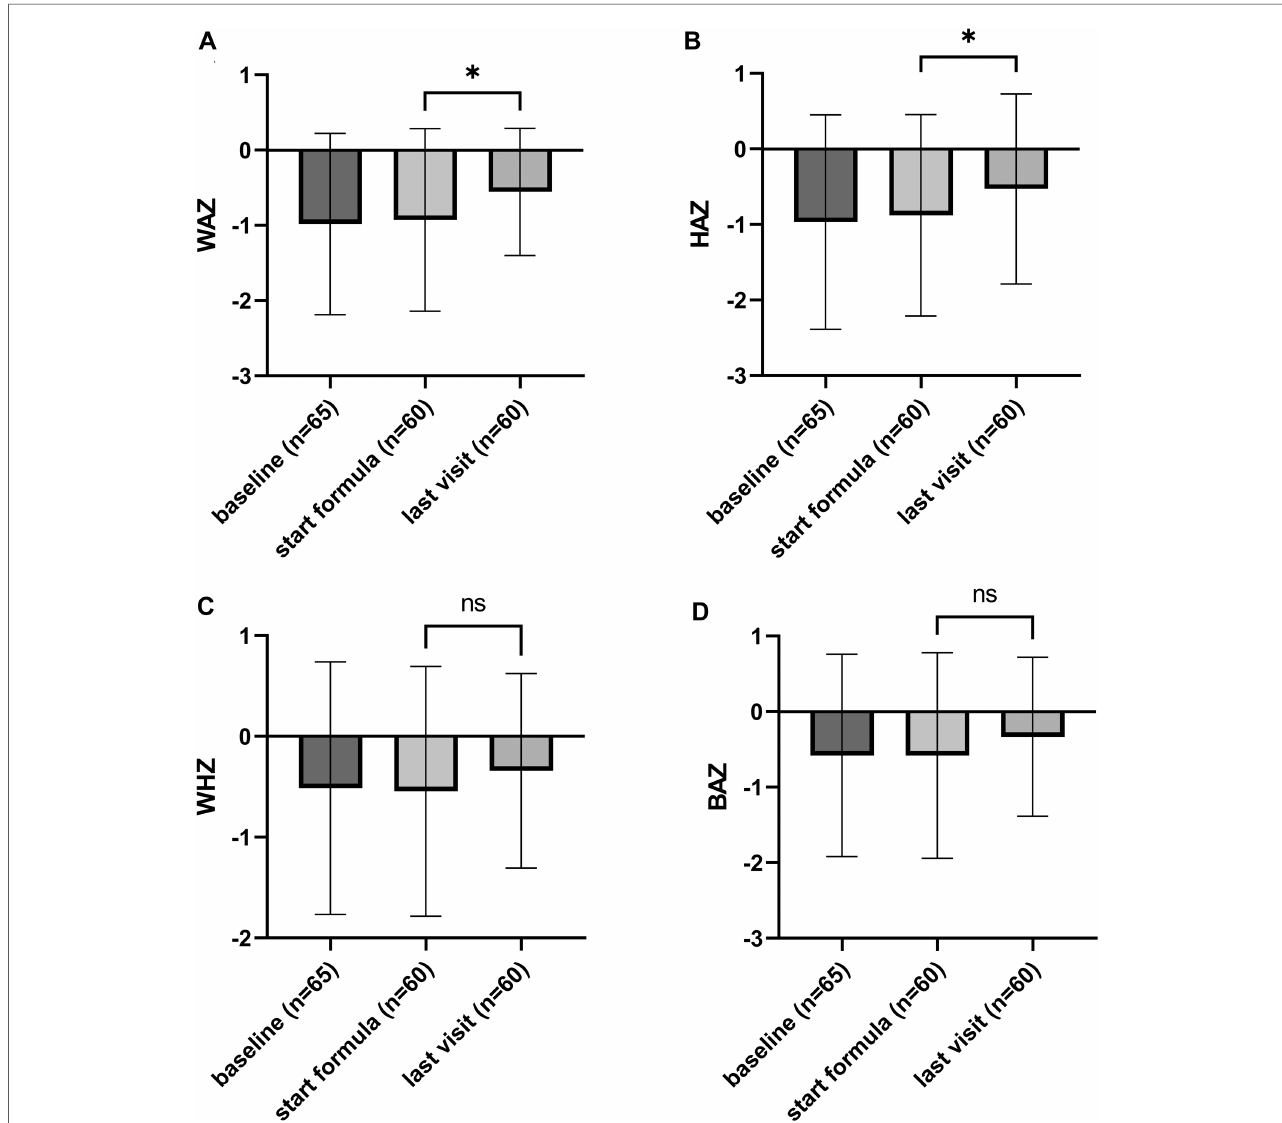
FIGURE 1 Growth outcomes of the study subjects consuming eHF-C, presented as Z-scores (mean±SD); ( A ) weight-for-age, ( B ) height-for-age, ( C ) weight-for-height, and ( D ) BMI-for-age Z -scores. Weight-for-age (WAZ) and height-for-age (HAZ) signi fi cantly improved during formula consumption ( p =0.02 and p =0.04